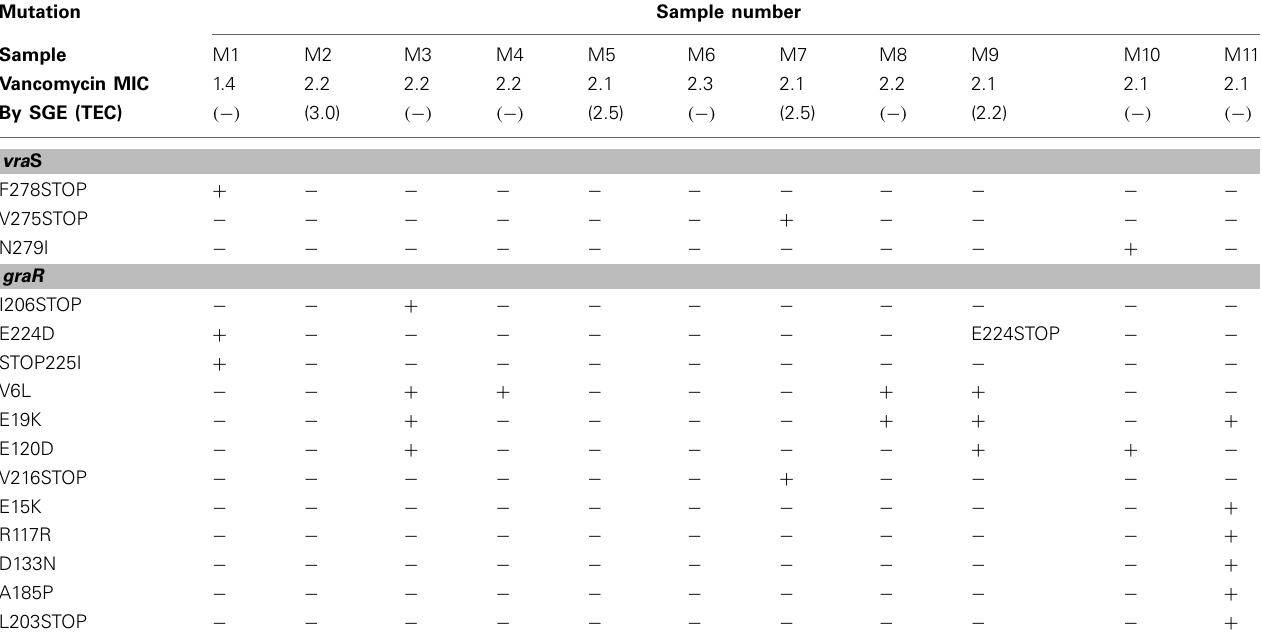
Table 2 | Presence of mutations observed in one vancomycin susceptible (M1) and 10 vancomycin non-susceptible (M2–11) porcine isolates in comparison with N315 (control